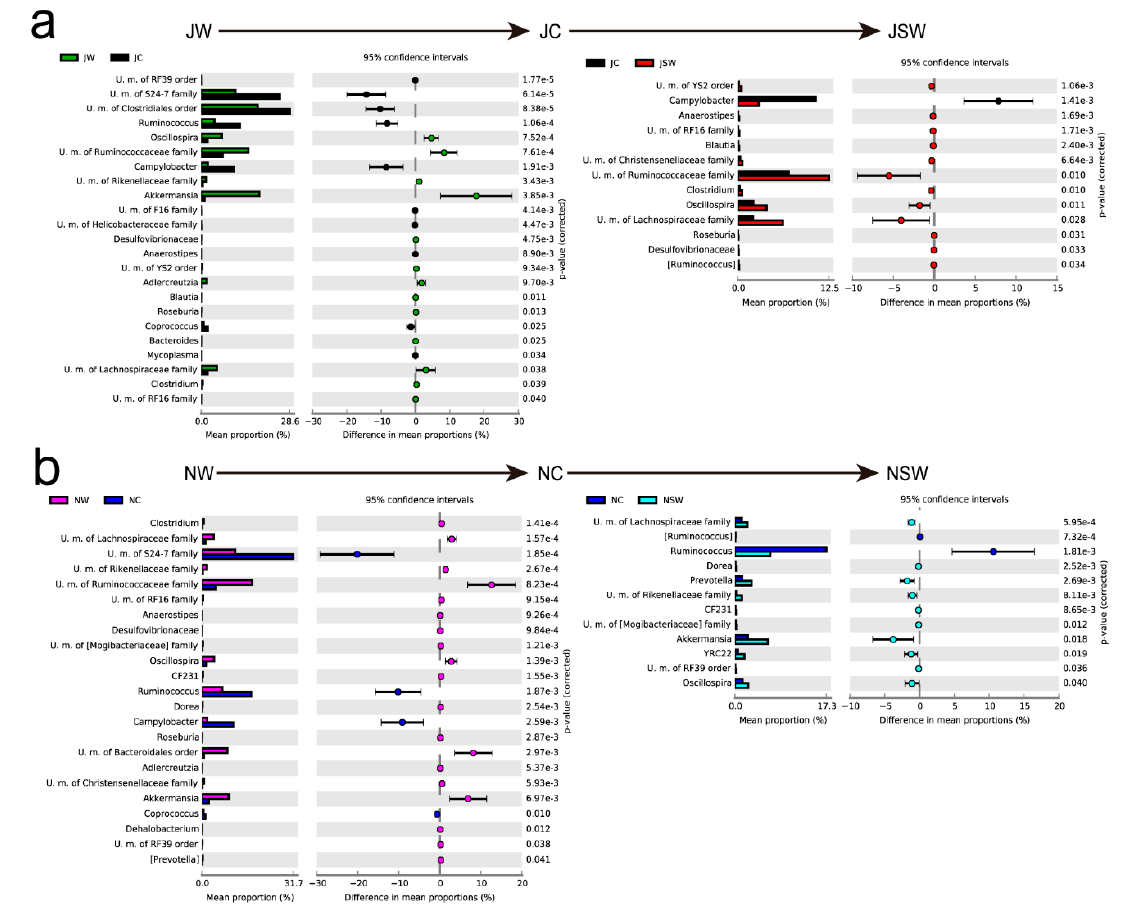
Figure 3. Response of dominant genera to interventions. ( a ) Changes in and resilience of genera in Group J. ( b ) Changes in and resilience of genera in Group N. Differences were assessed by the Welch’s t-test and denoted as the corrected p -value.